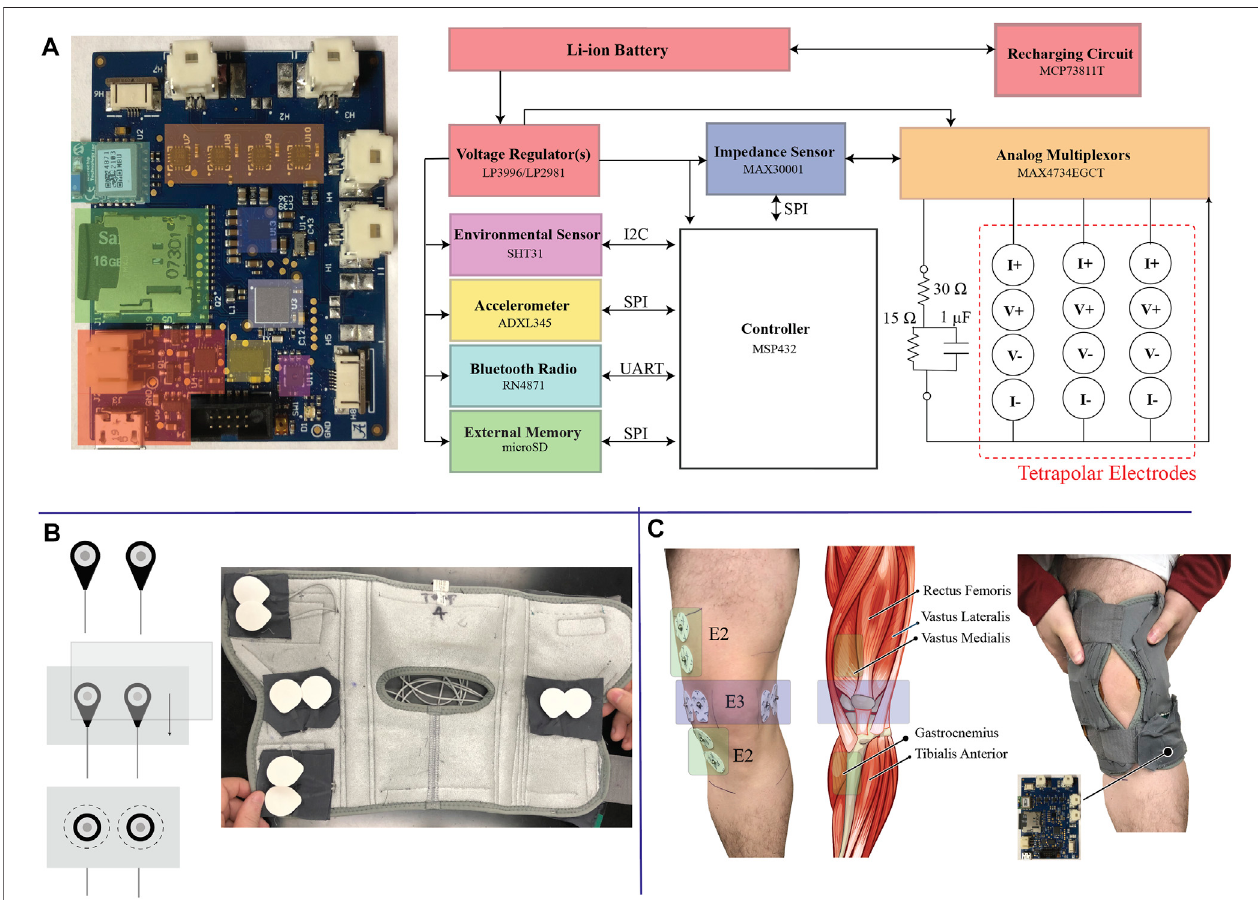
FIGURE1|(A) High-levelblockdiagramoftheelectronicsofthewearablesensorsystem, (B) electrodeintegrationintothecommercialbrace,and (C) illustrationof knee tissue locations that are measured by the wearable system after fi tting to a participants body.